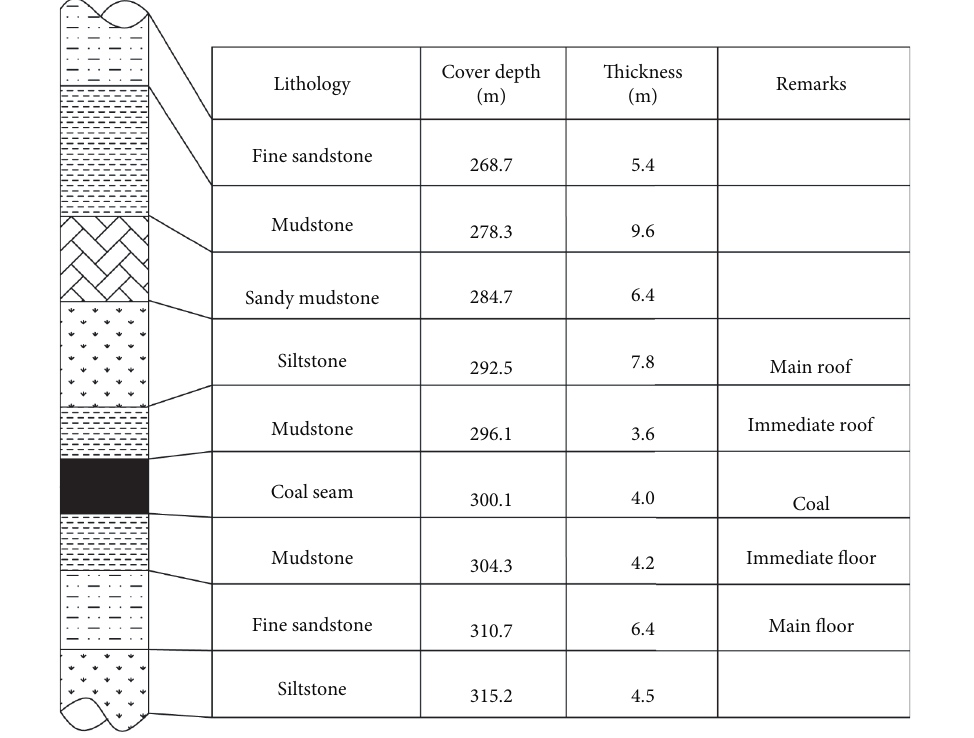
Figure 3: Rock histogram of the study site.